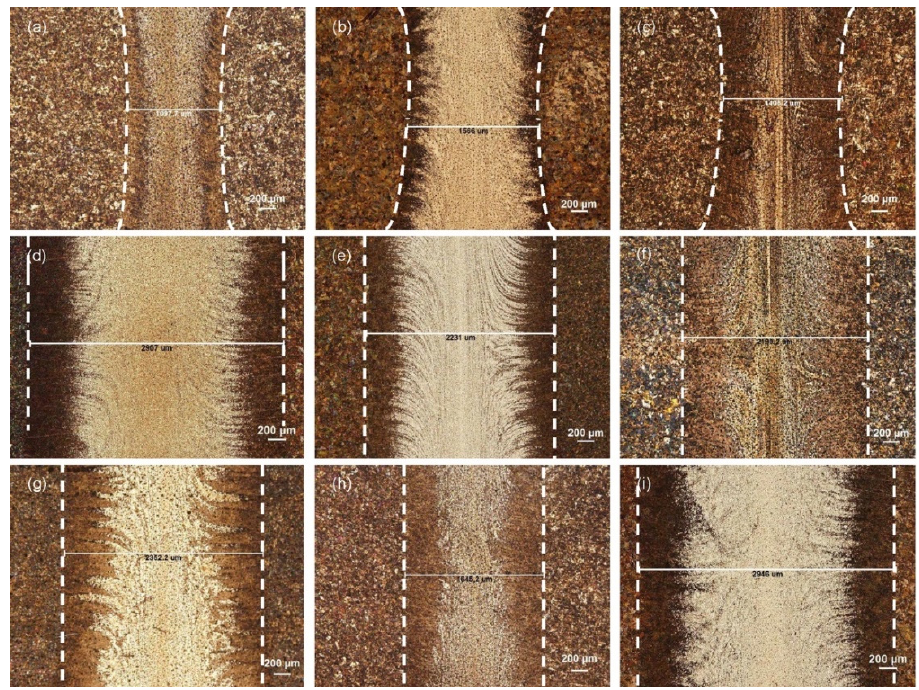
Figure 4. Optical micrographs of weld zone for nine specimens in all experimental groups: ( a – i ) represent Groups 1–9, respectively.